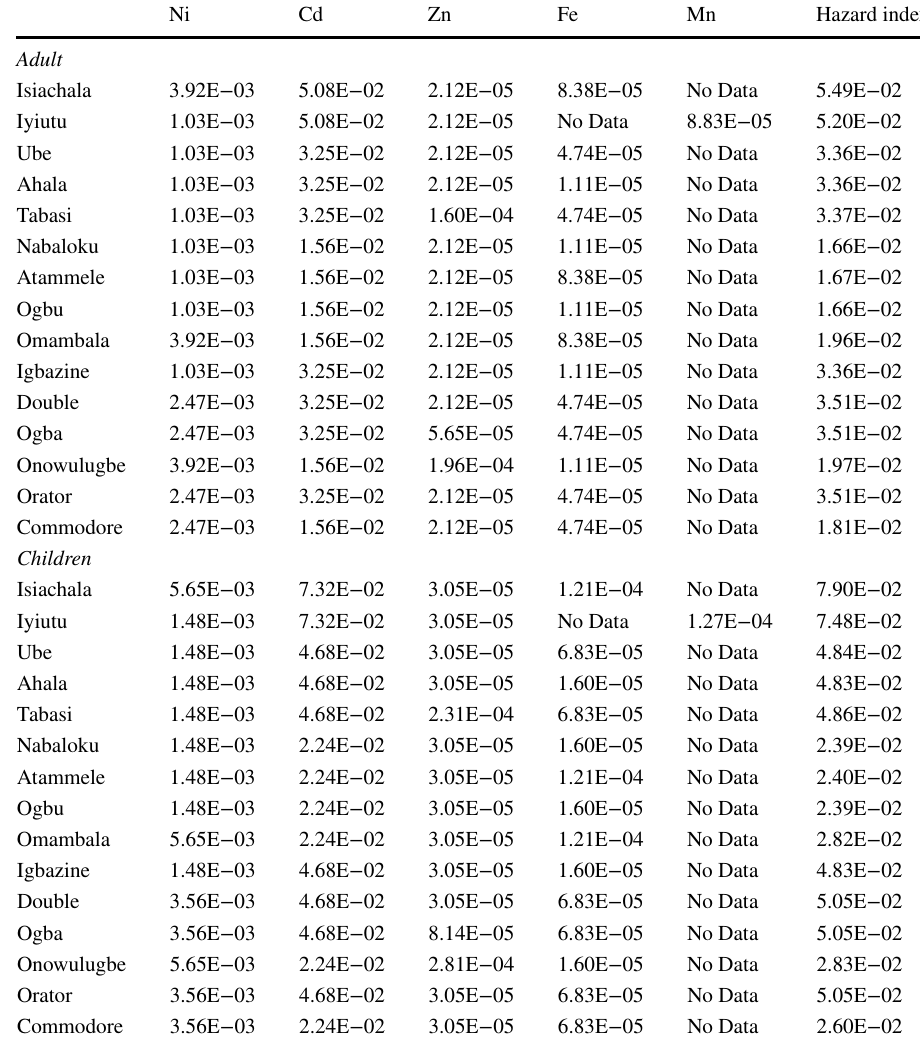
Table 11 Non-carcinogenic risk evaluation of heavy metals